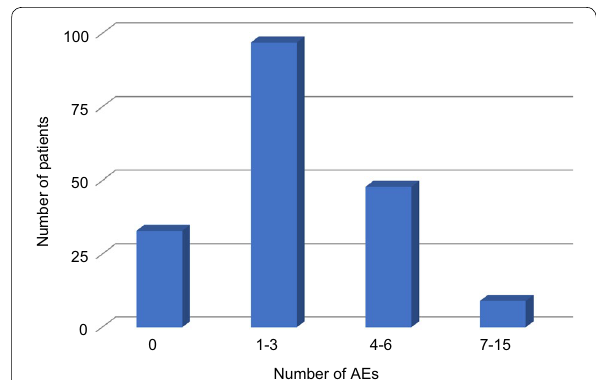
Fig. 1 The total number of patients experiencing adverse